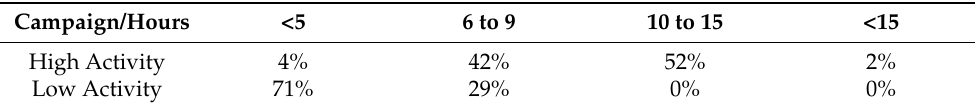
Table 3. Hours of work per